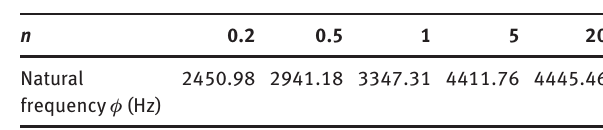
Table 3 Natural frequency of the FGM hollow cylinder with different values of n .